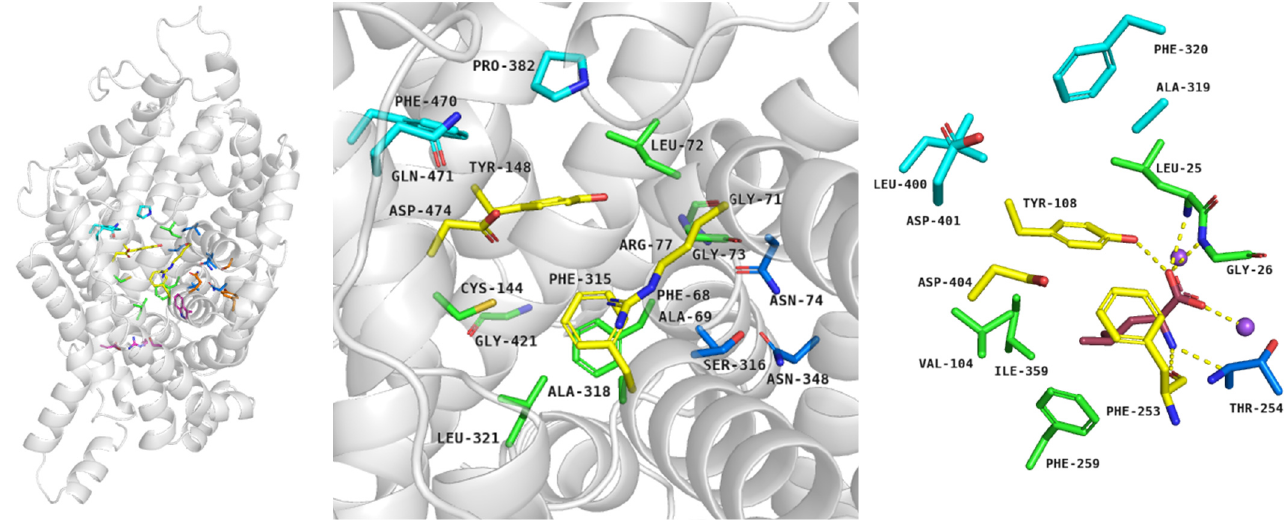
Figure 8. Spatial structure of transporters from SLC6 family in occluded conformation. Structure of creatine transporter was proposed by AlphaFold and analyzed in PyMOL: overall structure of CT-1 with selected residues ( left panel ), CT-1 binding site ( middle panel ). Binding mode of leucine within LeuT, PDB code: 2A65 ( right panel ). Residues coloured: blue—S2 site, yellow—extracellular gate, green—S1 site, navy blue—sodium ions binding site, pink—intracellular gate. Purple—leucine [18,75].